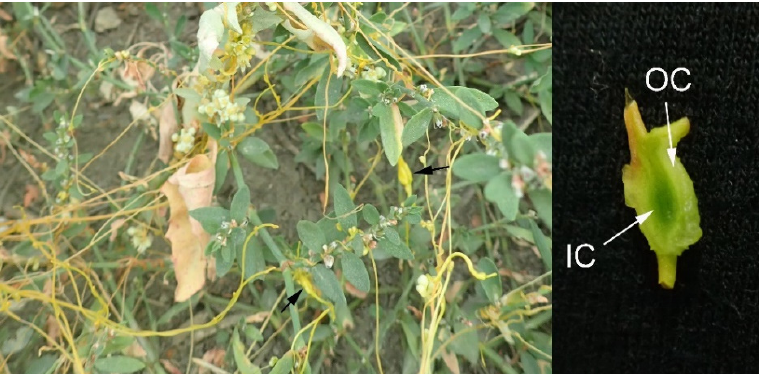
Figure 1. Yellowish stems of Cuscuta campestris on host Polygonum aviculare ( left panel ). Arrows indicate Smicronyx galls. Cross-section of a gall ( right panel ). The yellowish outer cortex (OC) and greenish inner cortex (IC) are indicated with